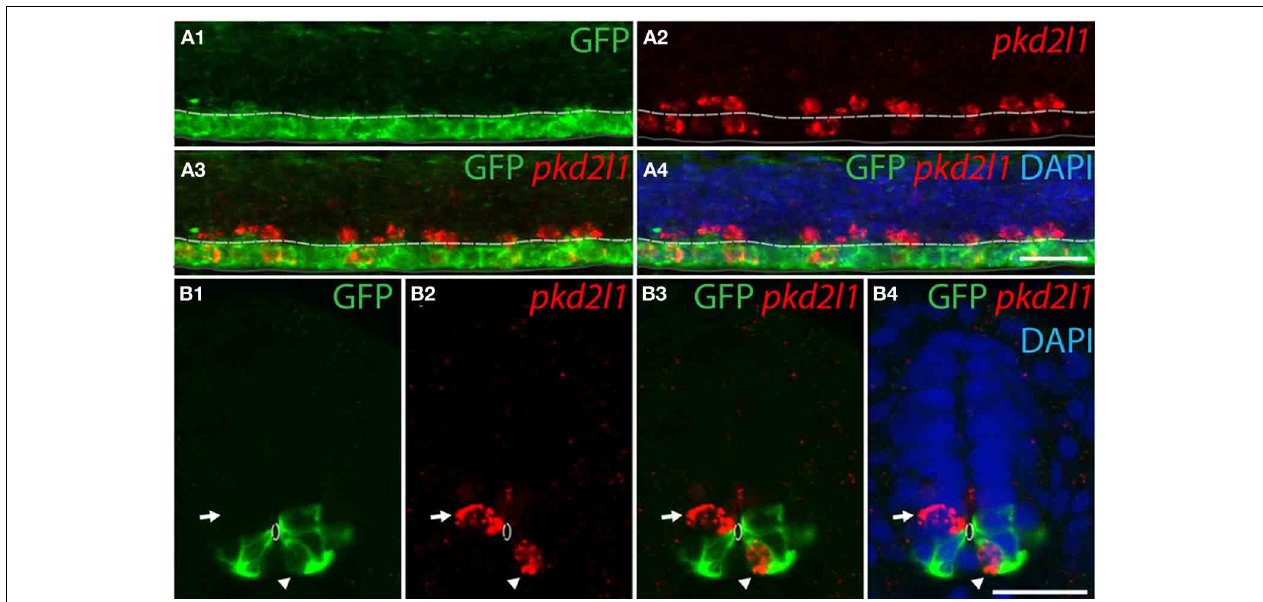
FIGURE 7 | Ventral pkd2l1 + cells express nkx2.2a and derive from the p3 progenitor domain in the zebrafish embryo. (A,B) pkd2l1 FISH in Tg(nkx2.2a: mEGFP) embryos immunostained for GFP at the 30-somite stage. IHC for GFP reveals the p3 domain. (A) Lateral view showing that the most ventral pkd2l1 + cells are GFP + . (B) A typical transverse section shows